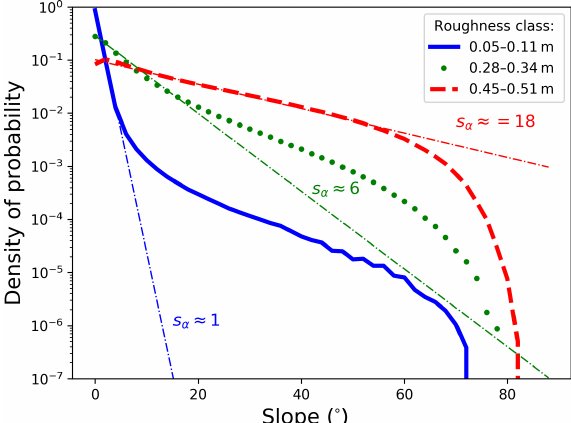
Figure 4. Density of probability of surface slopes on a logarithmic scale for three roughness classes: smooth 0.05m <σ z < 0.11m (in blue), medium rough 0.28m <σ z < 0.34m (in green), and rough 0.45m <σ z < 0.51m (in red). The exponential fits to the respective curves are marked as thin coloured dotted lines.